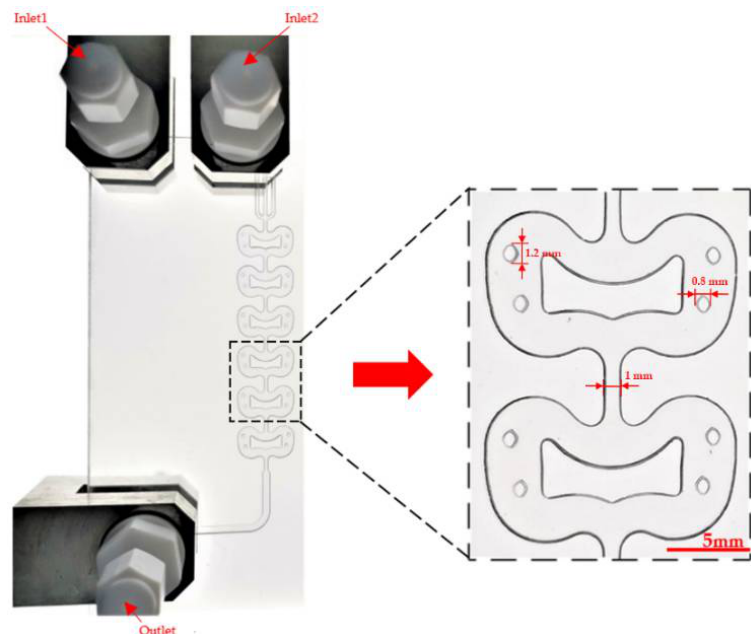
Figure 2. Image of the microreactor and the region of interest.